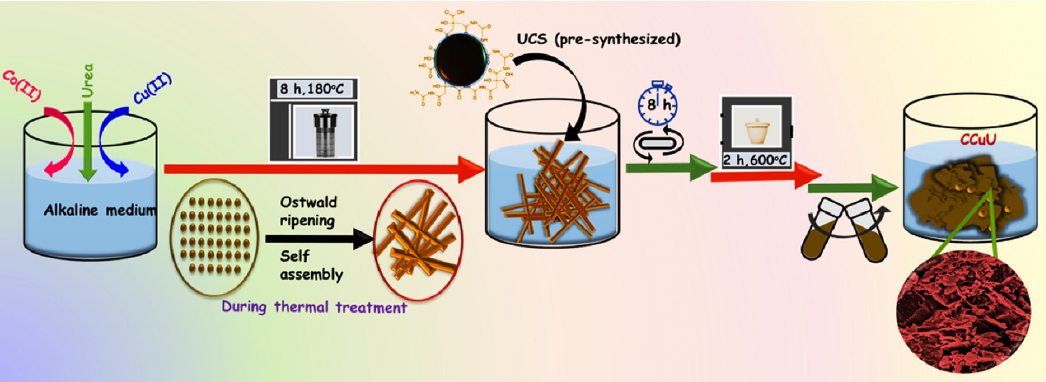
Figure 1. Schematic diagram of the synthesis of the CCuU composite. Other composites were synthesized through similar experimental process except the condition of precursor concentrations. The synthetic procedure has been provided in the supporting information.